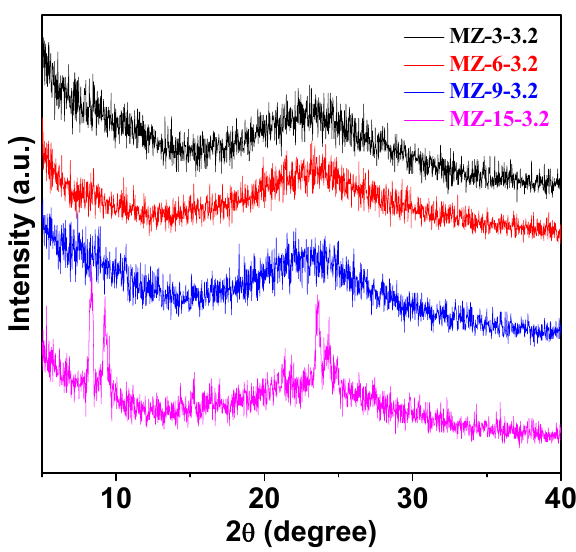
Figure 1. XRD patterns of MZ ‐ 3 ‐ 3.2, MZ ‐ 6 ‐ 3.2, MZ ‐ 9 ‐ 3.2, and MZ ‐ 15 ‐ 3.2.